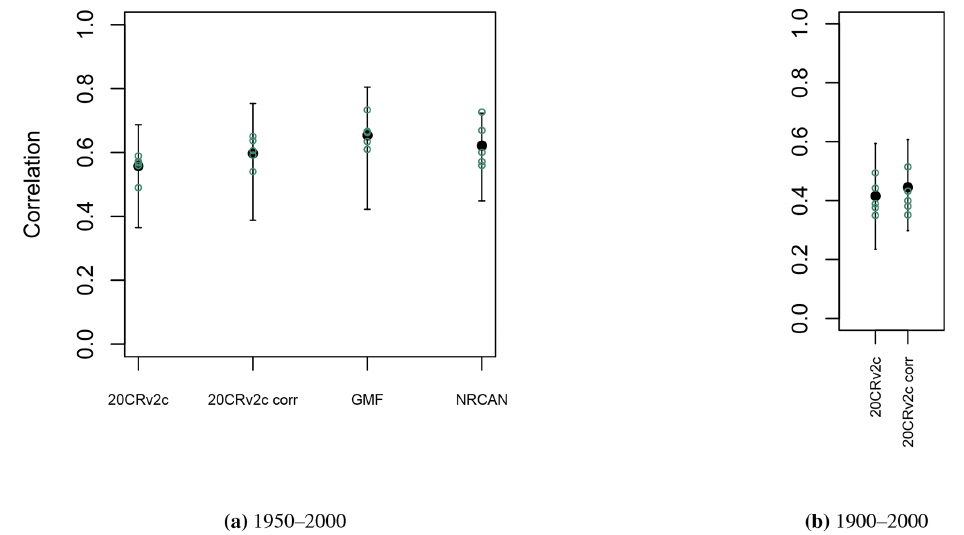
Figure 5. Pearson correlation coefficients (aggregated Eastern Canadian taiga sites (Fig. 1b), green circles), and mean and range of correla- tions (individual Eastern Canadian taiga sites used in aggregation (Fig. 1a and b), in black) between tree-growth observations and simulations with MAIDEN using the different climatic datasets described in Table 2 as inputs for the 1950–2000 (a) and 1900–2000 (b) calibration pe-